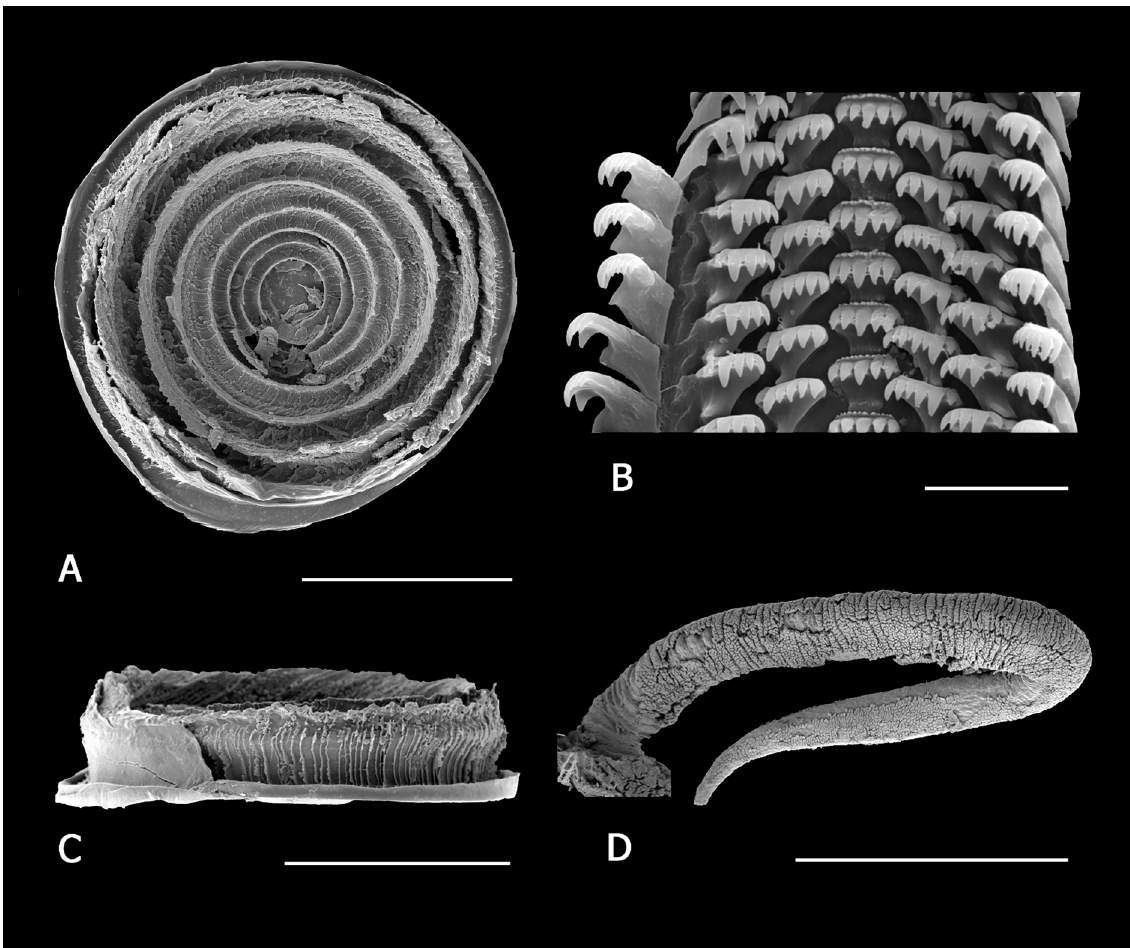
Fig. 35. Cyathopoma pembense Rowson, 2010. A–D . ELM D18464. A, C . Operculum. B . Portion of radula. D . Penis, lateral view. Scale bars: A, C–D = 500 µm; B = 20